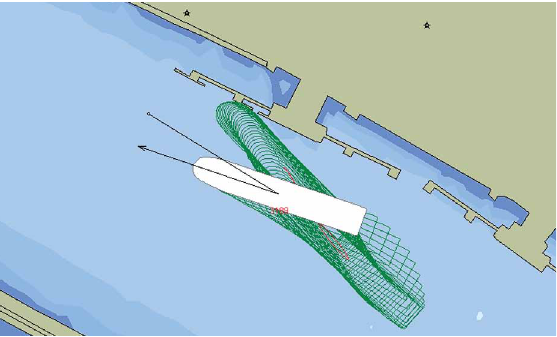
Fig. 10. PANAMAX tanker moving inside the port channel after unberthing with no tug assistance